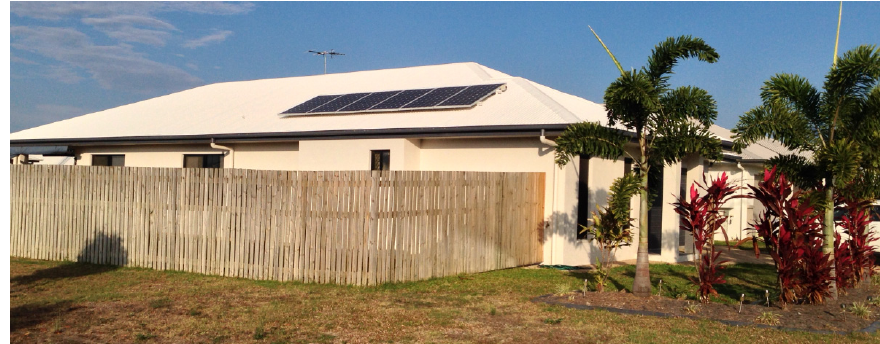
Figure 1. Residential building representing the case study.